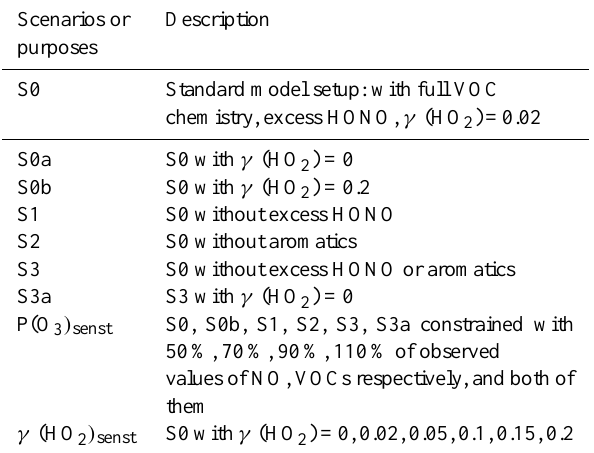
Table 1. Sensitivity simulation